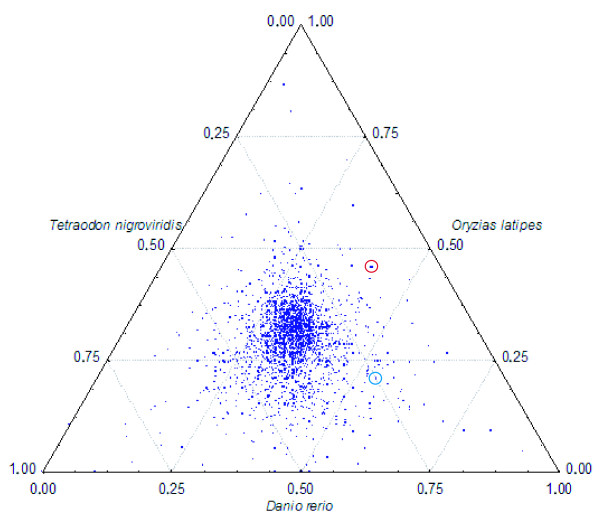
Example of a ternary representation of distances of fish species to human orthologs (Danio rerio, Oryzias latipes, Tetraodon nigroviridis). The red circle represents Lysyl-oxidase-like-1 (LOXL-1), a gene with significantly lower distance from Tetraodon nigroviridis to the human ortholog than to other fish species. The blue circle represents the ankyrin repeat domain 10, a gene with significantly higher distance from Danio rerio to the human ortholog than to other fish species.